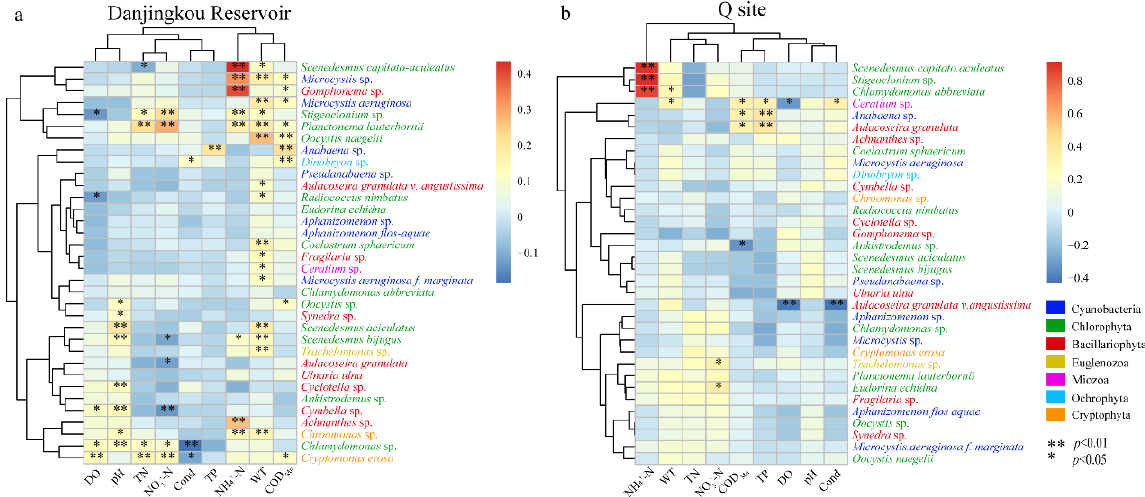
Figure 8. Heatmap of correlation between phytoplankton dominant species abundance and environmental parameters. (( a ) Danjiangkou Reservoir; ( b ) Q site).